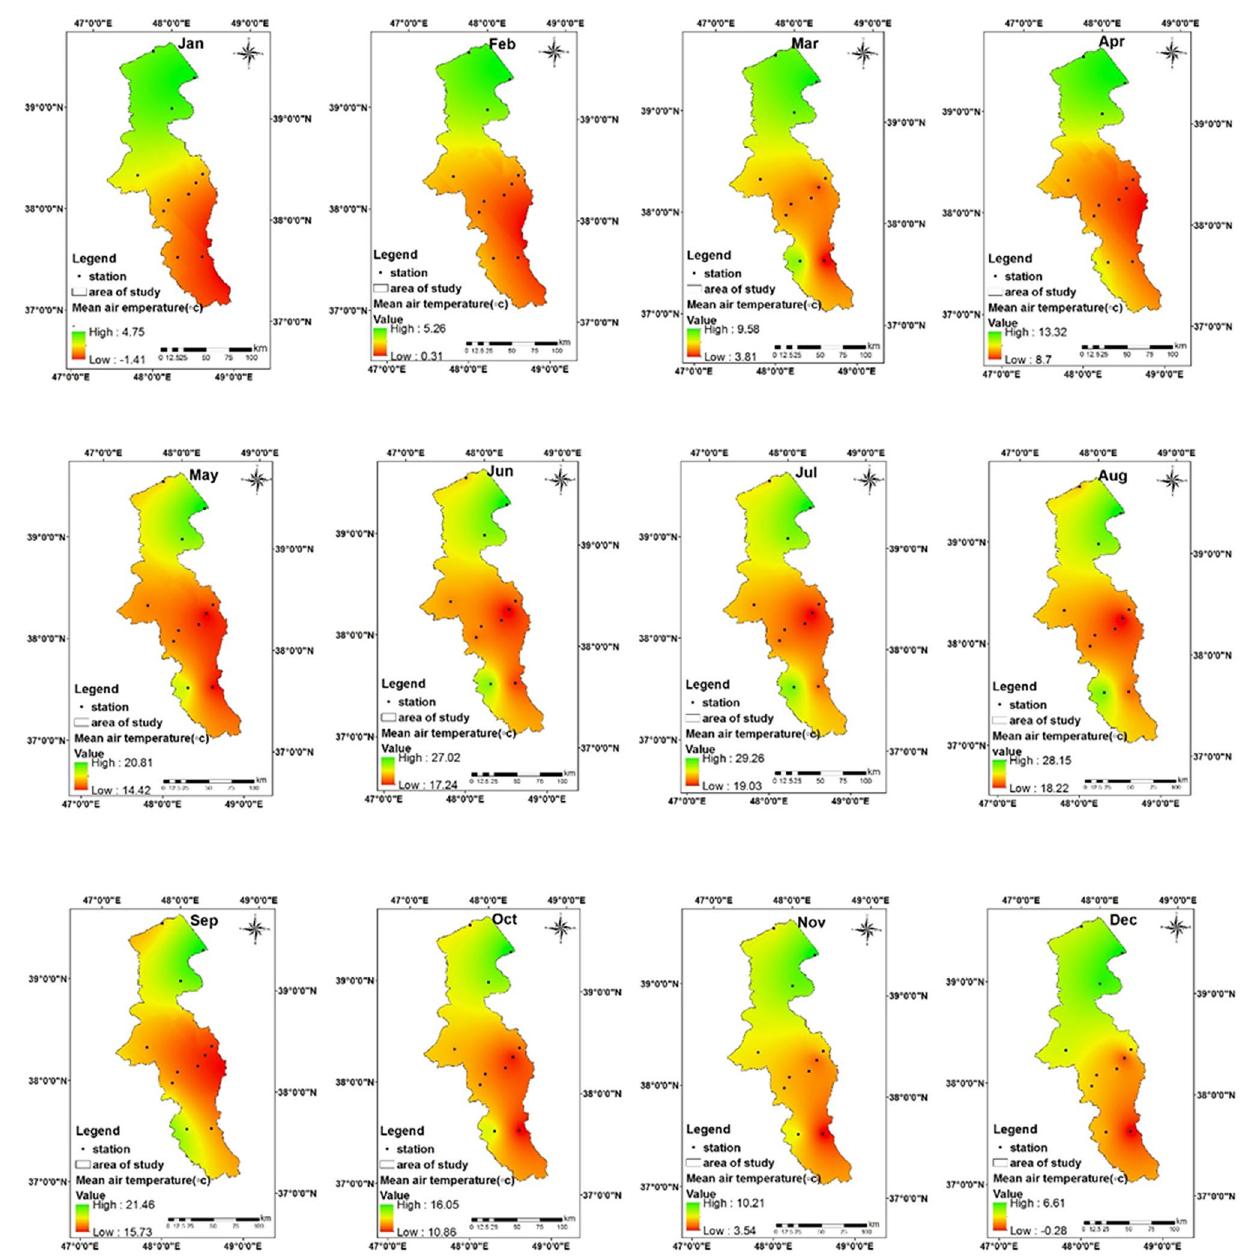
Fig. 3 Thematic temperature mean maps of the time evolution month by month for